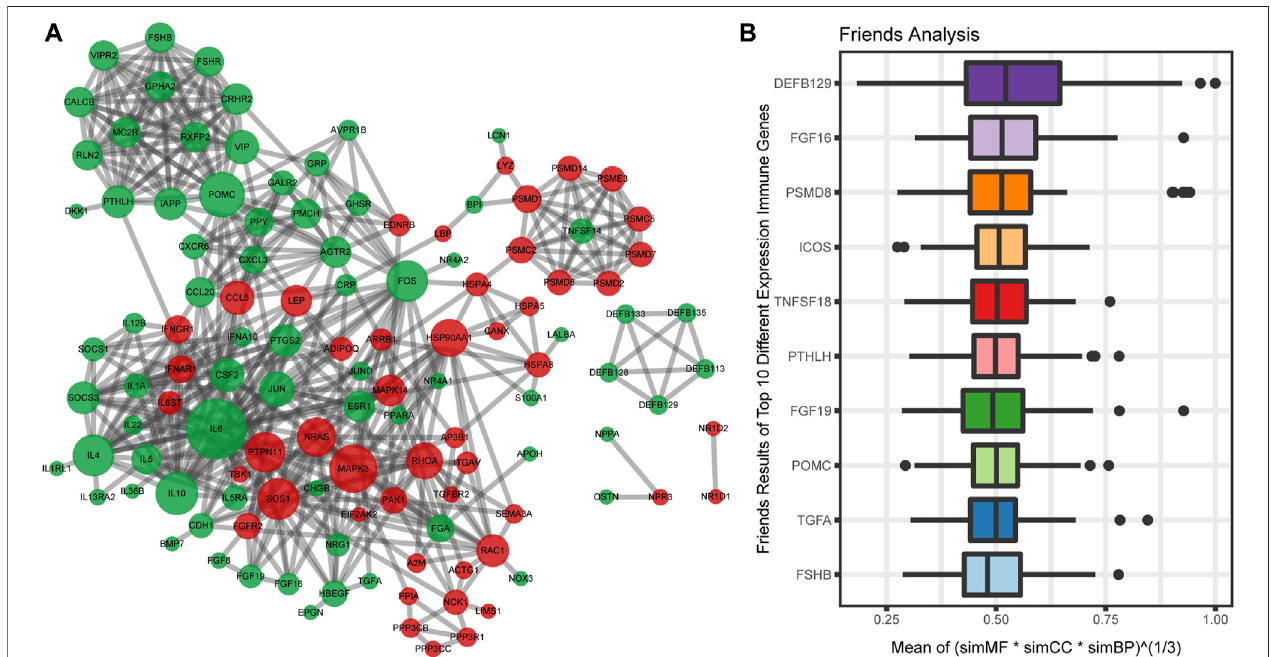
FIGURE 4 | Protein-protein interactions (PPI) network construction and semantic similarity analysis of immune-related DEGs. (A) The PPI network of immune- related DEGs. Each circle represents a gene. The upregulated genes (red) and downregulated genes (green) are represented by circles. Different sizes indicate the core degree of genes in the PPI network, whereas bigger size indicates more important in the network. (B) Summary of functional similarities of the top 10 immune-related DEGs. The aggregate score is between 0 and 1. The higher the score is, the more similarity genes